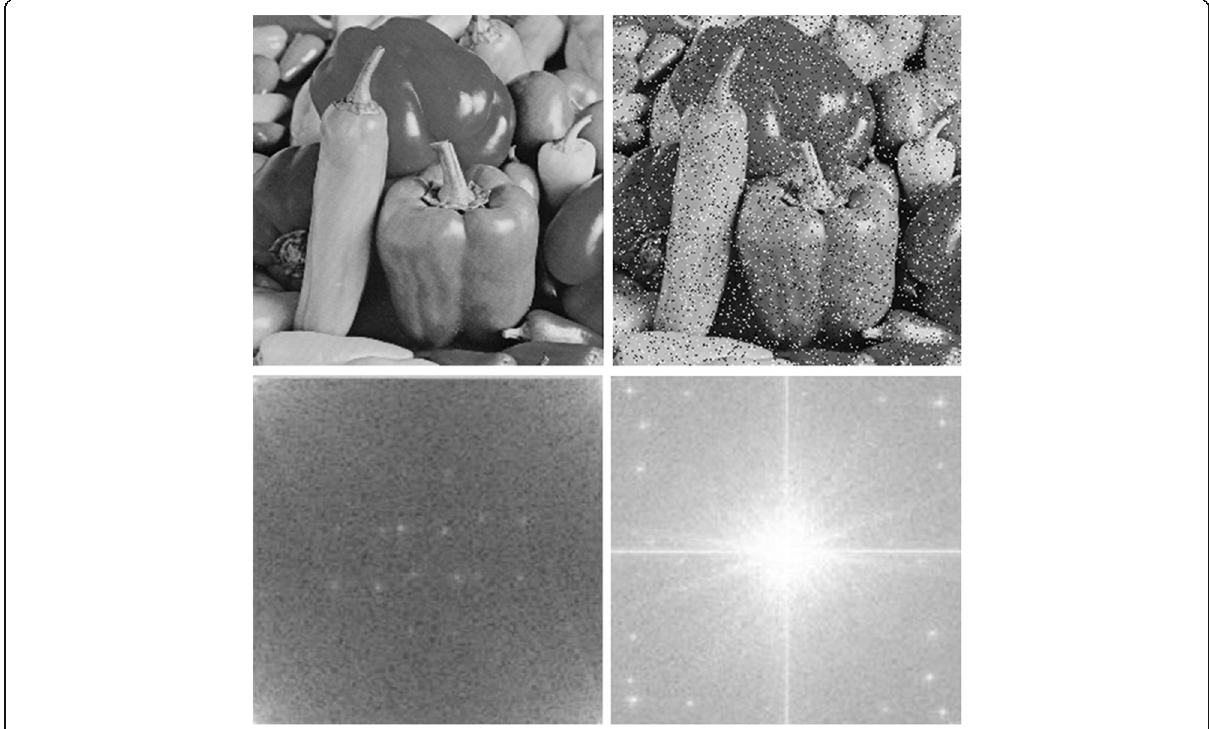
Fig. 6 Peppers test images (the upper left is the original peppers ’ image, the upper right is the noisy image, the lower left is the frequency spectrogram of original peppers ’ image, and the lower right is the frequency spectrogram of the noisy